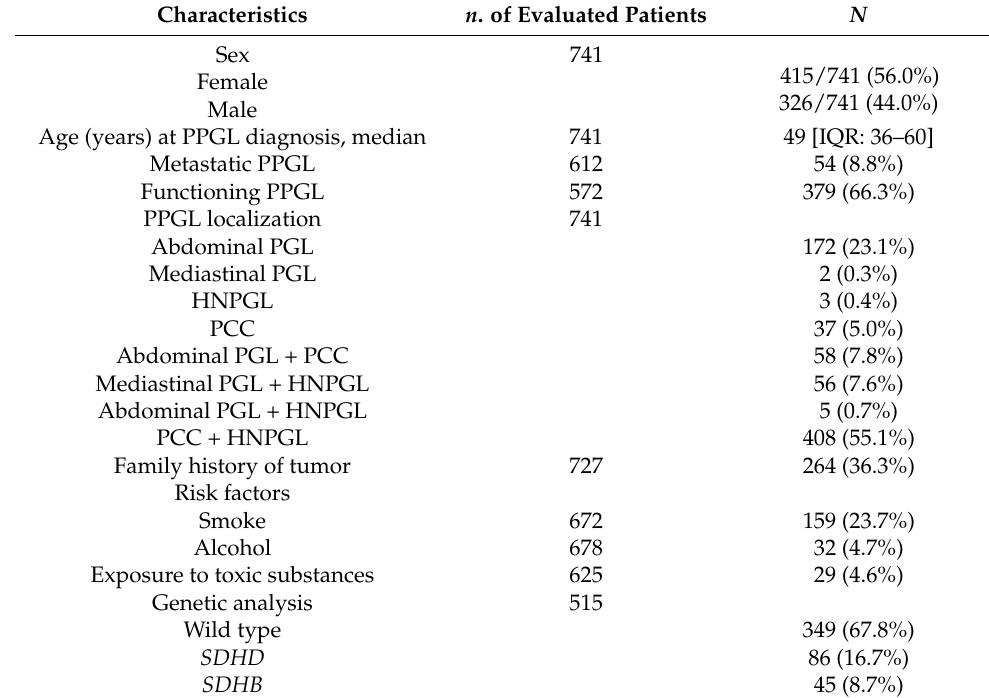
Table 1. Patient characteristics.